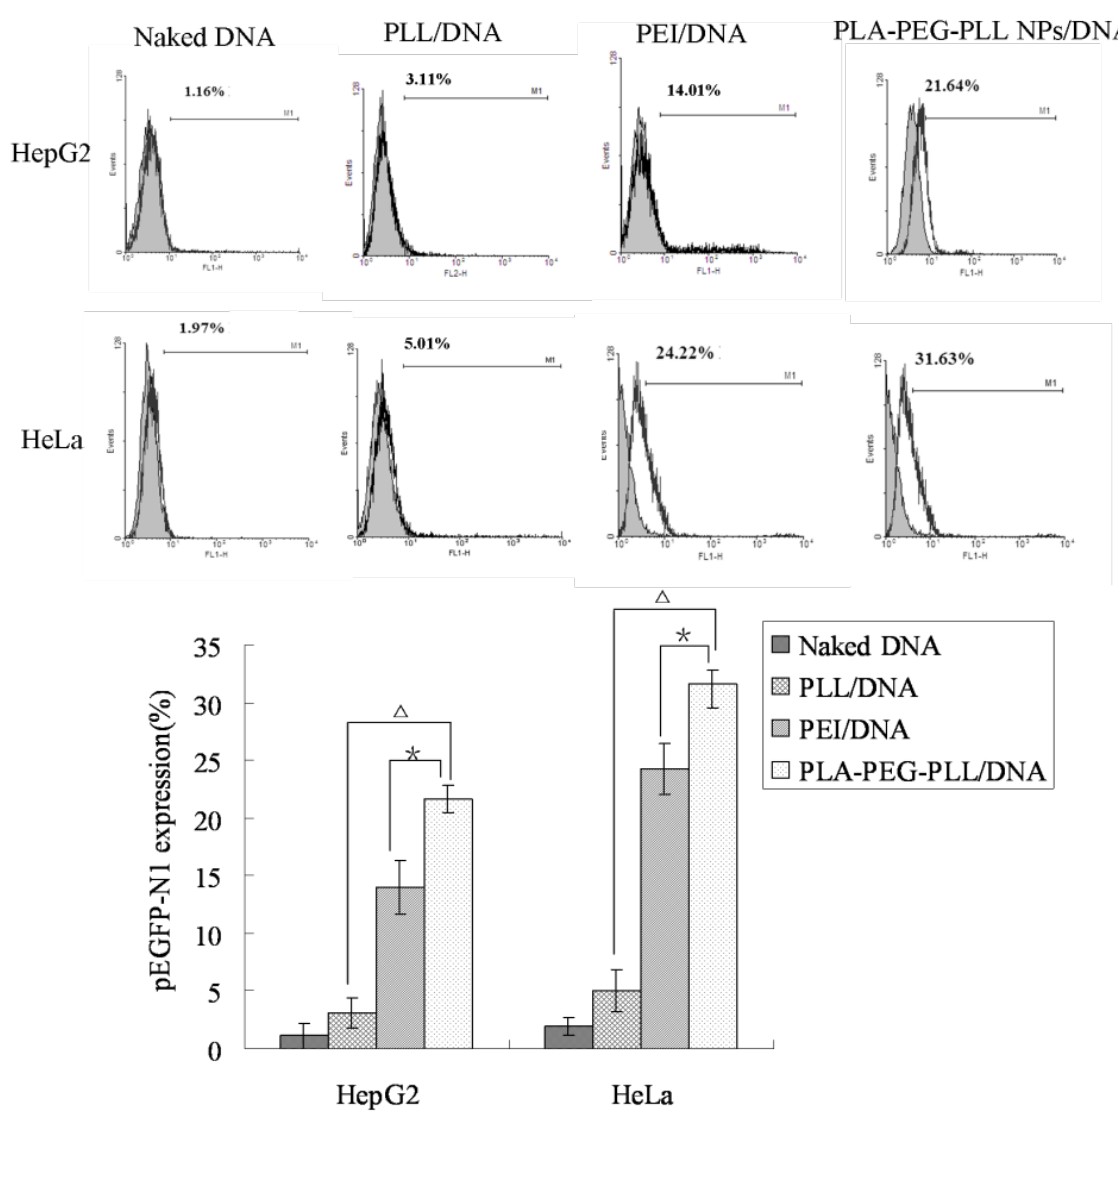
Figure 10. Flow cytometry of HepG2 (top panel) and HeLa cells (bottom) transfected with pEGFP-N with naked DNA, PLL/DNA, PEI/DNA and PLA-PEG-PLL NPs/DNA 1 complexes. Gene expression was measured 24 h post transfection. The reported transfection efficiency is the ratio of the number of cells producing fluorescent signal to the number of total cells. (* P < 0.05 compared with PEI/DNA complexes, ∆ P < 0.01 compared with PLL/DNA complexes, n =